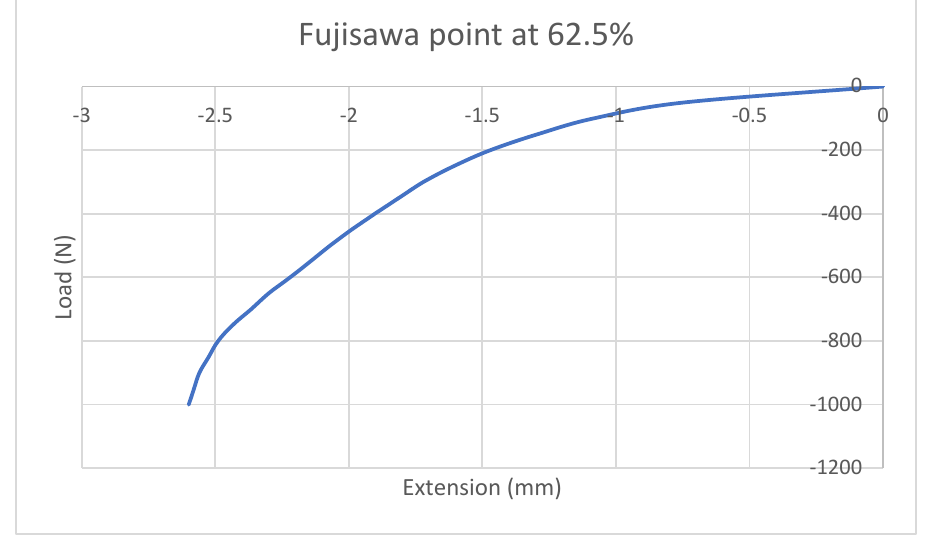
Figure 6. Variation of the force relative to the displacement—offset loading at the Fujisawa point.